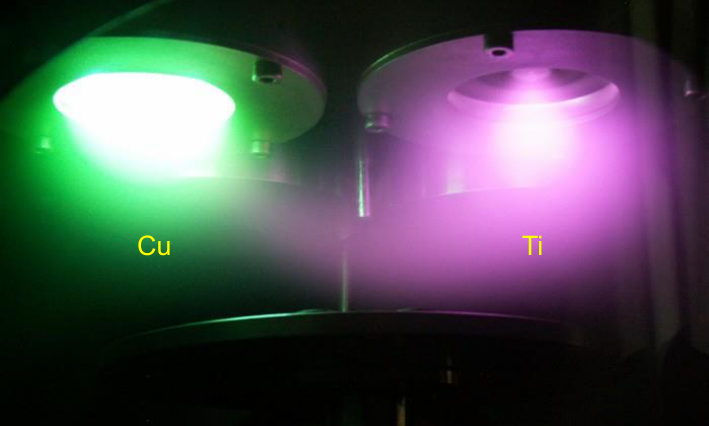
Figure 1. Photo showing both magnetrons with Cu and Ti targets during a HiPIMS pulse applied to the Cu